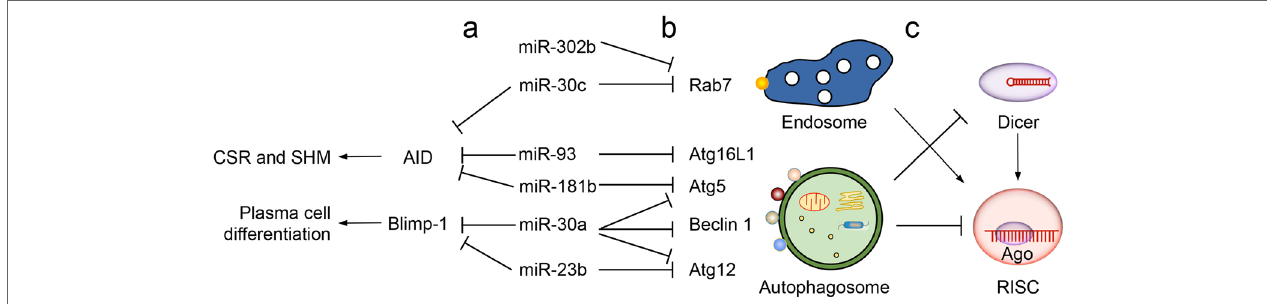
FiGURe 2 | Cross-regulation of intracellular membrane-associated proteins and microRNAs in B cell differentiation . (a) Regulation of multiple intracellular membrane-associated proteins as well as AID (critical for CSR/SHM) and Blimp-1 (driving plasma cell differentiation) by a single microRNA. For example, miR-30a regulates Atg5, Beclin 1 and Atg12 in autophagy and Blimp-1, miR-30c regulates Rab7 (in the endosome pathway) and AID, as well, miR-93 and miR-181b regulate AID as well as Atg16L1 and Atg5, respectively. (b) Regulation of one intracellular membrane-associated protein by several microRNAs. For example, Rab7 is regulated by both miR-30c and miR-302b, and Atg12 is regulated by both miR-30a and miR-23b. (c) Regulation of microRNA activities by endosomes and autophagosomes. Endosomes provide a structure to support the assembly of RISC in microRNA-mediated gene silencing. Autophagosomes promote degradation of Dicer and Ago, thereby downregulating microRNA biogenesis and functions,